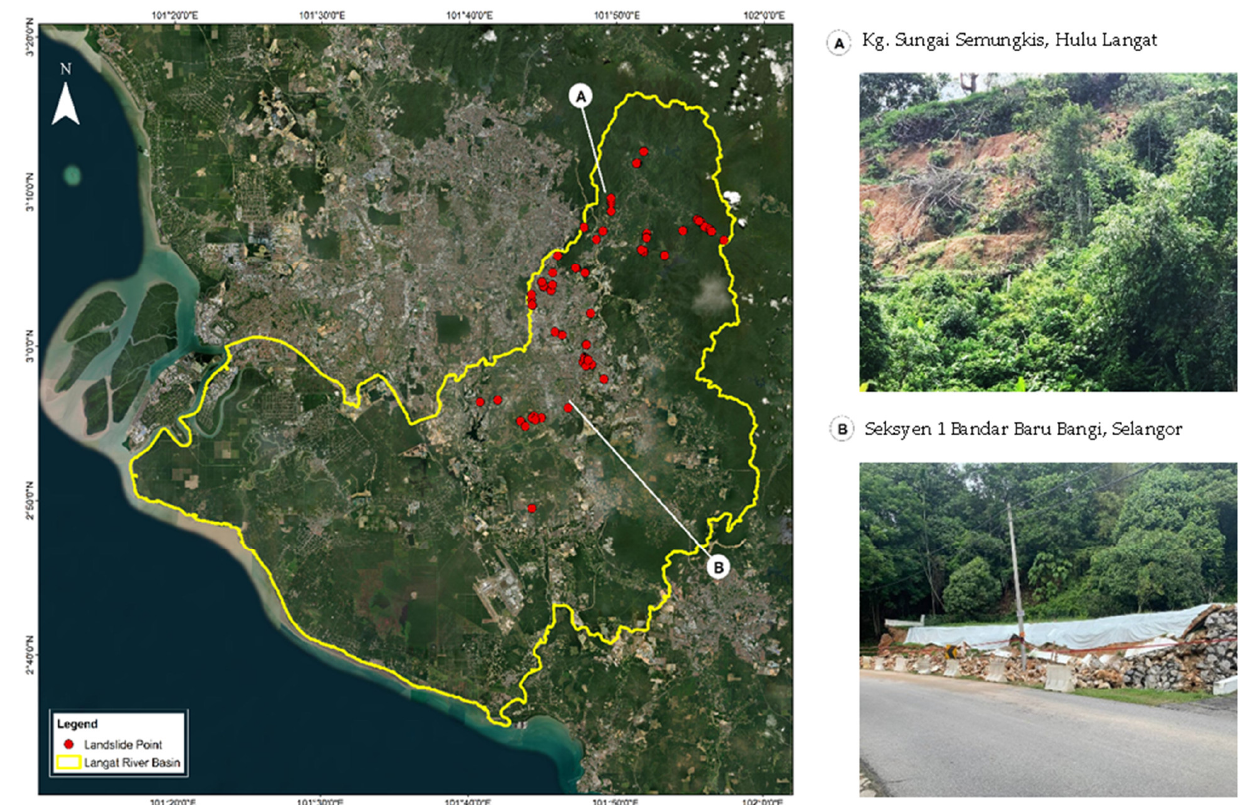
Figure 3. The landslide location at Langat River Basin (Photos were taken in December 2021).